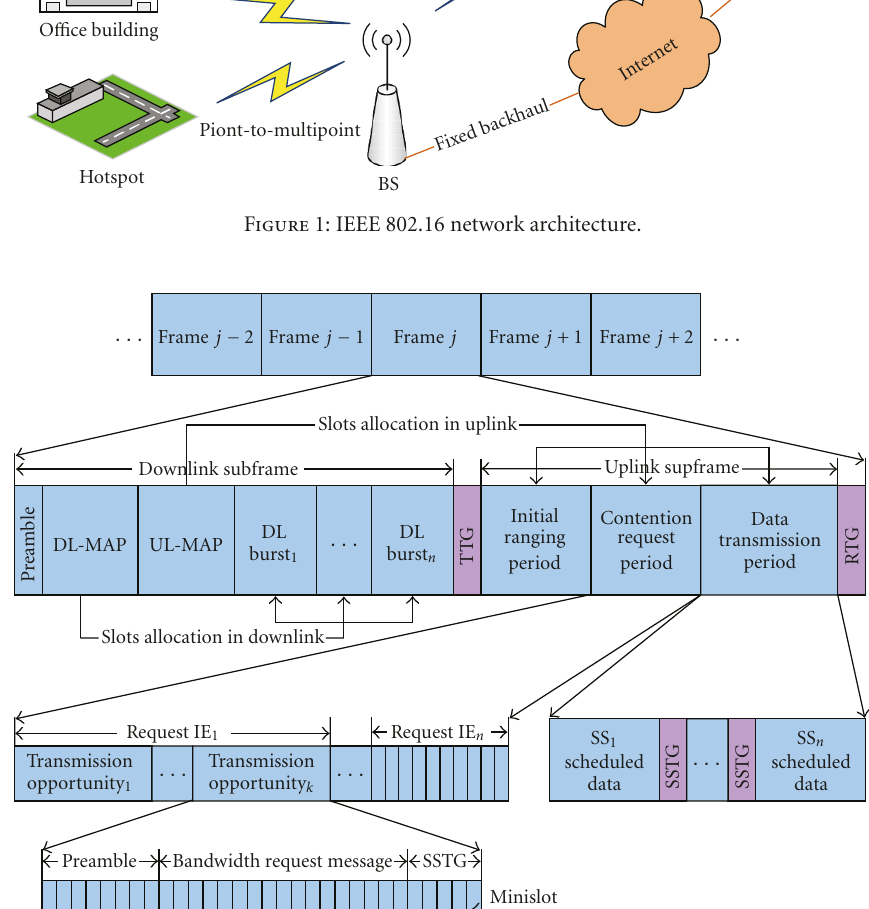
Figure 2: Frame structure of IEEE 802.16